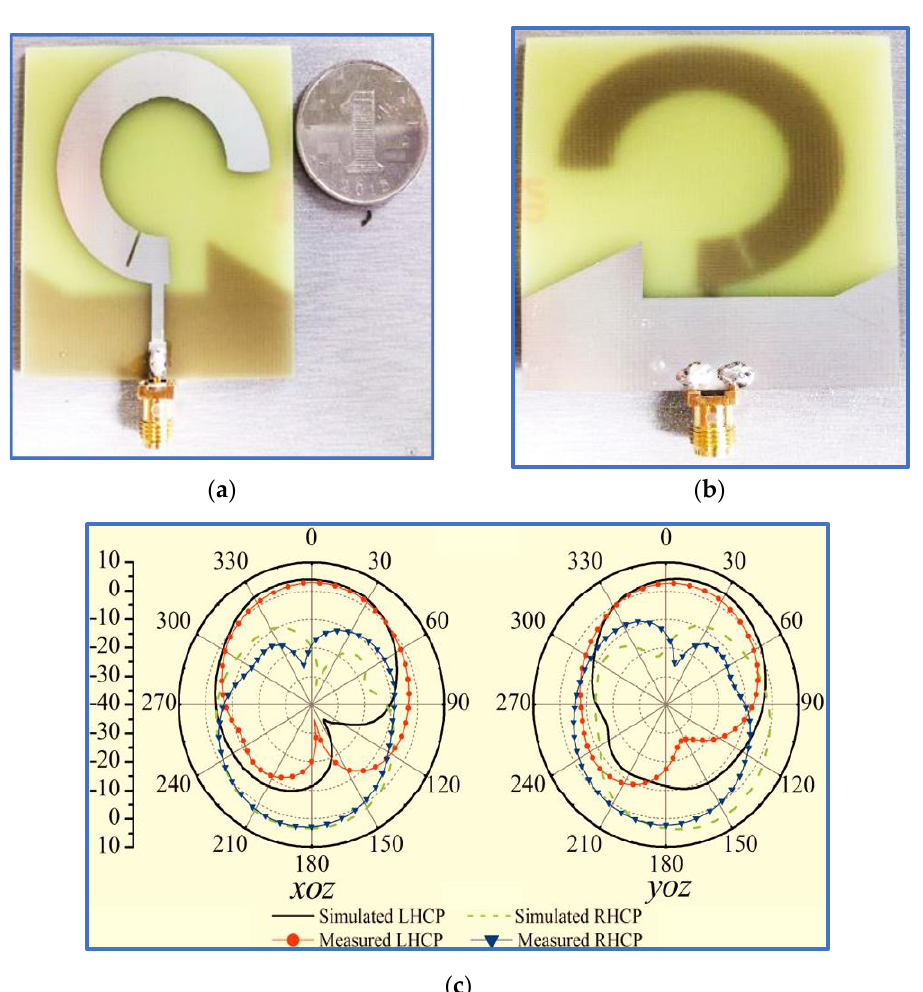
Figure 22. The geometry of a C-shaped monopole antenna: ( a ) front view; ( b ) back view; ( c ) radiation pattern at 2.4 GHz [123].